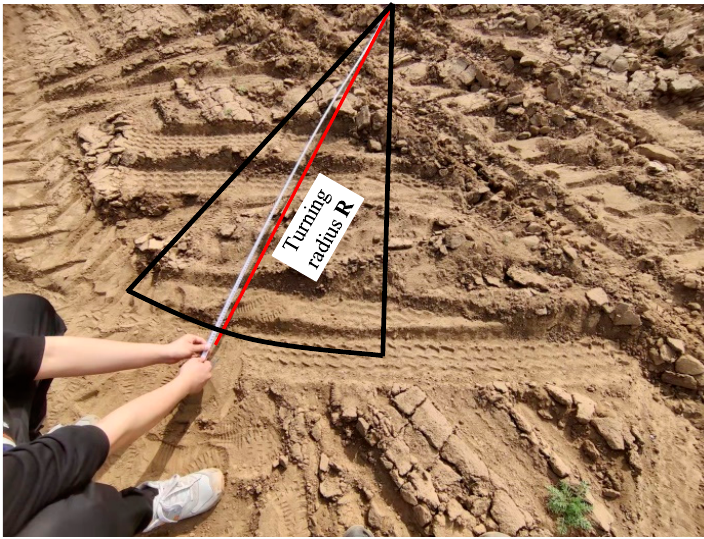
Figure 20. Turning radius test experiment.